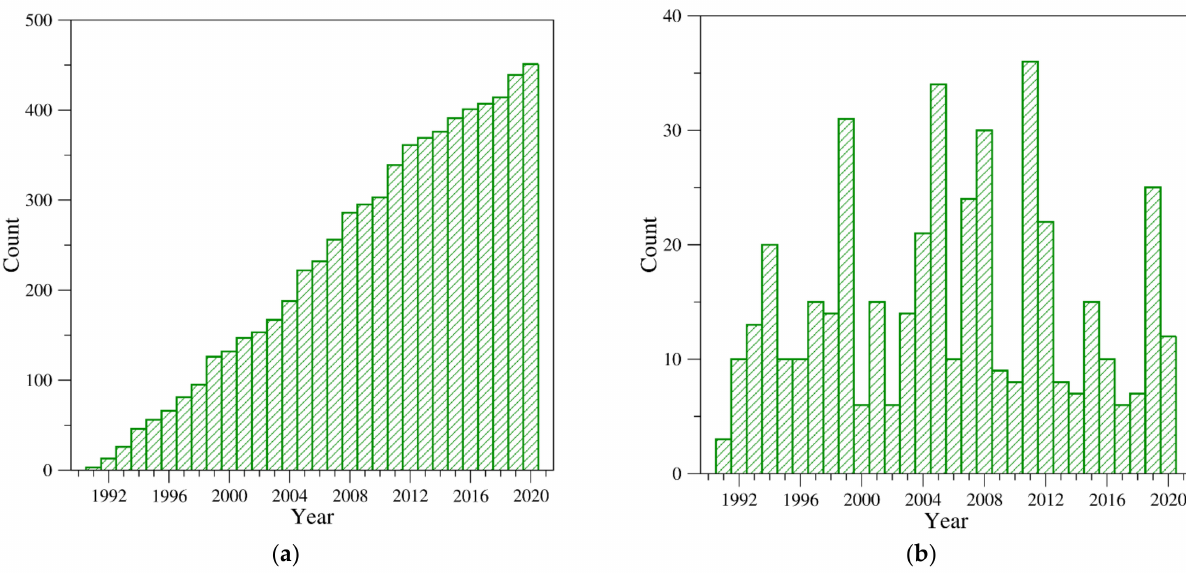
Figure 4. PDB entries containing at least one α -thrombin chain: ( a ) the cumulative temporal growth of these structures and ( b ) the number of structures deposited per year. Structures were selected by considering all PDB entries released within 2020 containing at least one chain with a sequence identity higher than 75% when compared with α -thrombin (Uniprot code: P00734). Considering the length of the thrombin (295 residues), in order to exclude protein fragments and precursors, the ensemble content was further refined by considering polypeptide chains with a number of residues comprised between 200 and 300. This survey yielded a structural ensemble of 451 structures from the following species: Homo sapiens (421 structures), Bos Taurus (23), and Mus Musculus